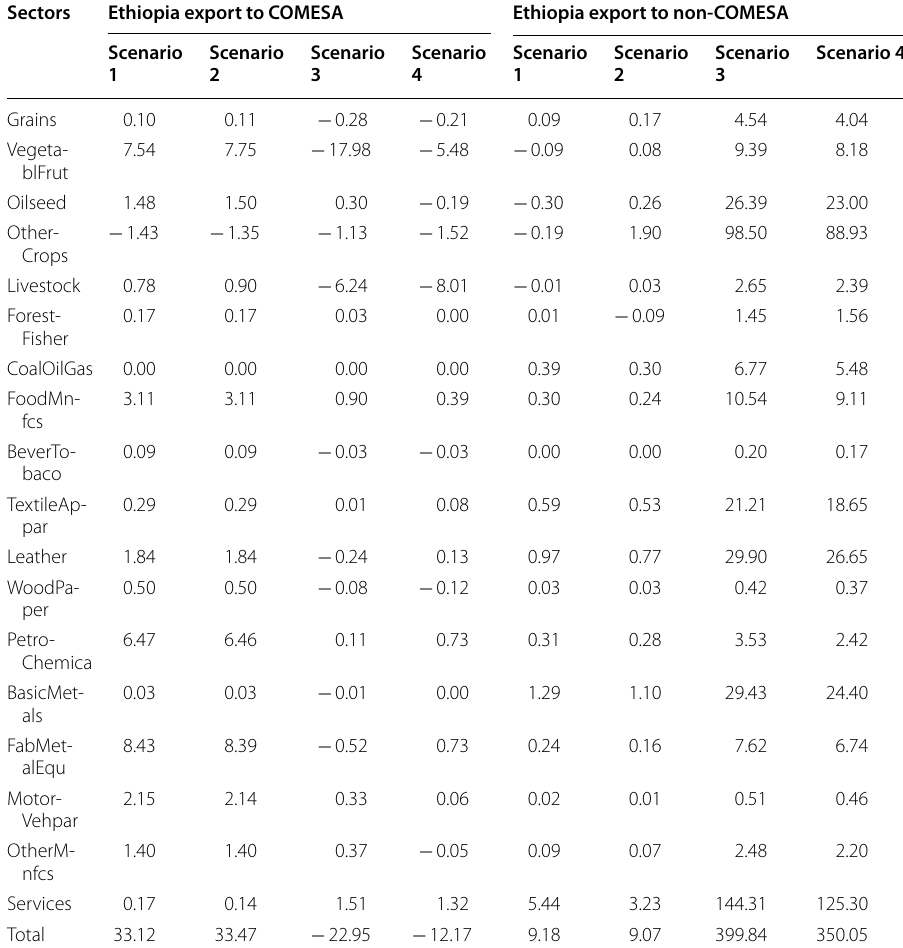
Table 13 Changes in Ethiopia’s export by destination (US$ Million). Source: Model